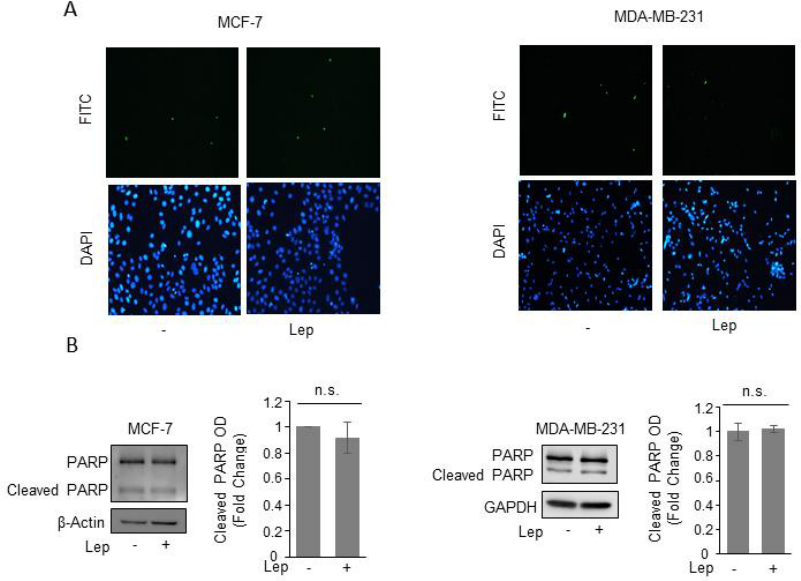
Figure 3. Leptin does not induce apoptotic cell death in breast cancer cells. ( A ) Terminal deoxynucleotidyl transferase-mediated dUTP nick end labeling (TUNEL) staining in MCF-7 and MDA-MB-231 cells treated with vehicle (-) or Leptin (Lep, 500 ng/mL) for 48 h. DAPI was used for nuclear staining. ( B ) Immunoblot analysis of PARP and cleaved-PARP protein levels from total MCF-7 and MDA-MB-231 cellular extracts. β-Actin and GAPDH were used as a control for equal loading and transfer. The histograms represent the mean ± S.D. of three separate experiments in which band intensities were evaluated in terms of optical density arbitrary units (OD) and expressed as fold change versus vehicle-treated samples. n.s. nonsignificant.